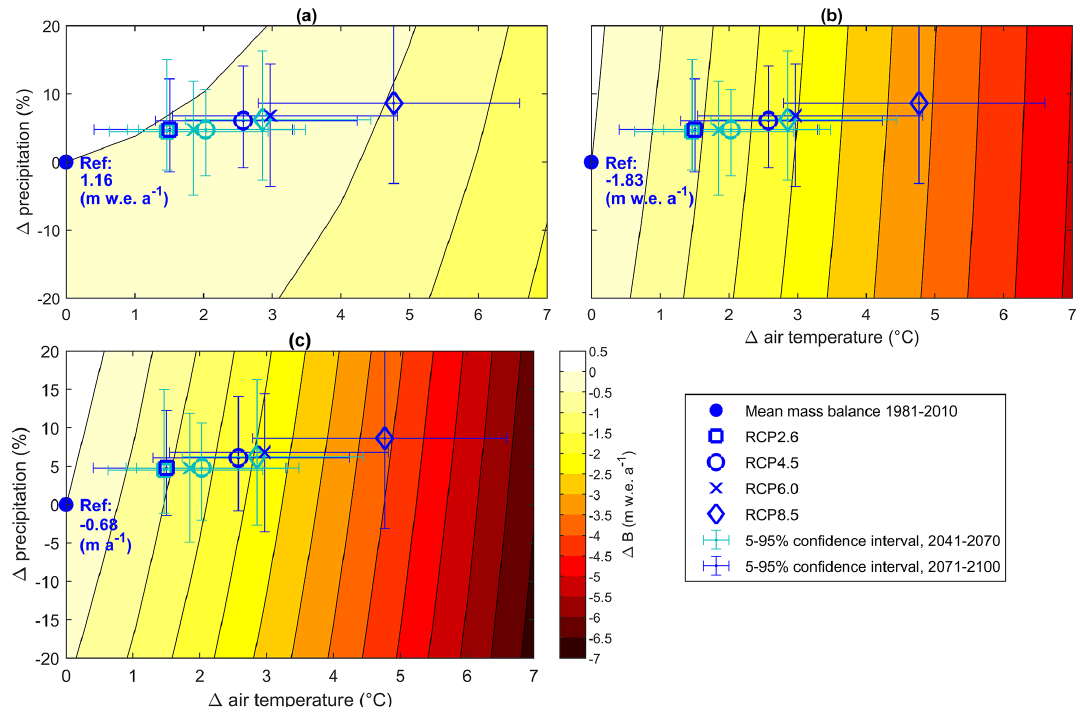
Figure 12. Reference (2010) mass balance sensitivity to prescribed changes in regional mean air temperature between 0 and 7 ◦ C and precipitation between − 20% and + 20%, which encompass IPCC RCP ensemble scenarios RCP2.6, RCP4.5, RCP6.0 and RCP8.5 for the mid (2041–2070: dark blue) and late (2071–2100: light blue) 21st century. The mean seasonal and annual mass balance are shown for the reference period 1981–2010. (a) Winter balance ( B w ); (b) summer balance ( B s ); (c) annual balance ( B a ). r2010 r2010 r2010